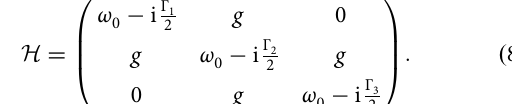
which marks the border between the regime when the PT ^ Hamiltonian H 0 is in its unbroken phase with real eigenvalues, ffiffiffi p Þ , and the broken phase with complex eigenvalues, 2 g ≥ κ = ð 2 ffiffiffi p Þ [cf. Eq. (1) for the dimer result, ð g = κ Þ N g < κ = ð 2 2 We plot the PT -symmetric regime eigenfrequencies ω 0 Fig. 1 using Eq. (11). The real parts are given in panel b, while the imaginary parts are displayed in panel c. The exceptional point of Eq. (13) is marked by the dashed gray line, and makes explicit the broken and unbroken PT -symmetric phases. There are several features of Fig. 1 which are shared amongst all odd-sited oligomers, namely: the purely real resonance frequency ω 0 (orange line) is always a valid eigenfrequency; two eigenfrequen- cies always become complex in the broken PT -symmetric phase; and these two aforementioned eigenfrequencies are always the two eigenfrequencies closest to ω 0 (neglecting the aforemen- tioned, guaranteed ω 0 eigensolution). Under the popular classi fi cation where an n th order exceptional point refers to when n eigenvalues coalesce at the exceptional point 46 , Fig. 1b, c exposes a higher order exceptional point of the 3rd order (compared to 2nd order for a dimer, see Supplementary Note